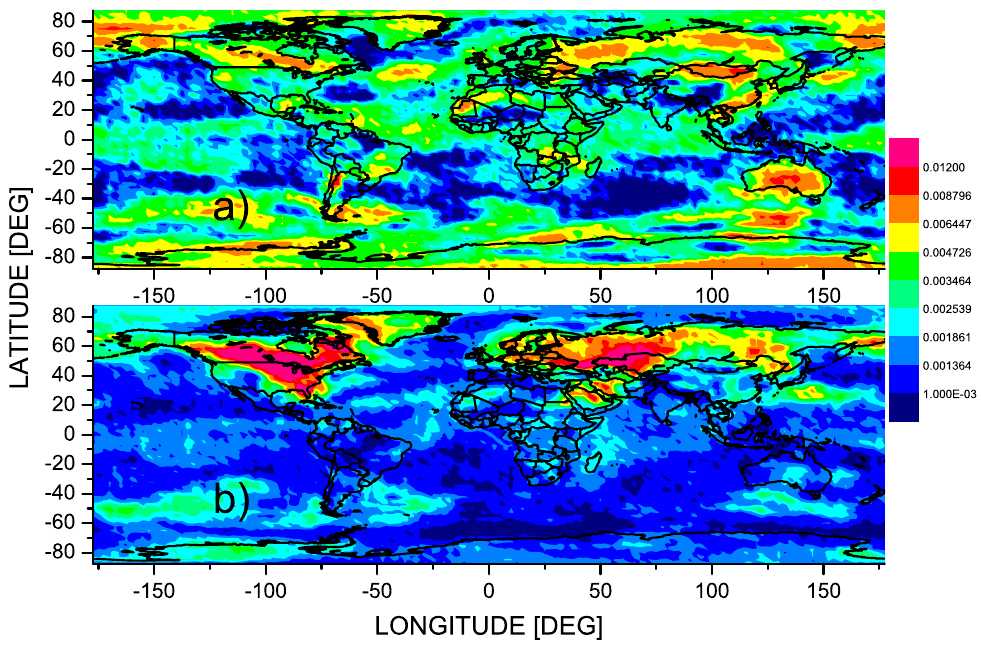
Fig. 10. Area weighted connectivity for SATA climate networks with density % = 0 . 005 obtained by thresholding of the absolute correlation Z -scores related to independent univariate FT surrogate data for negative (a) and positive (b) NAO index.